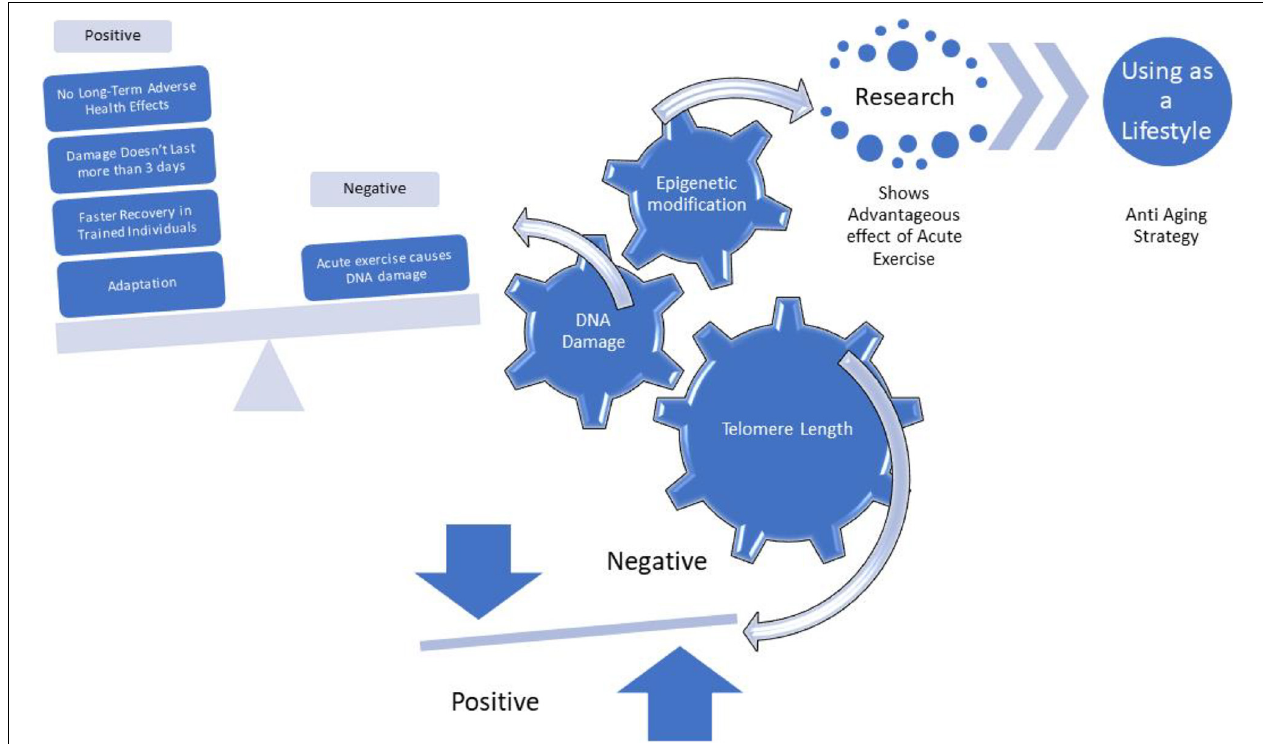
FIGURE 1 | An overview of effects of Acute Exercise on Telomere Length, DNA Damage and Epigenetic